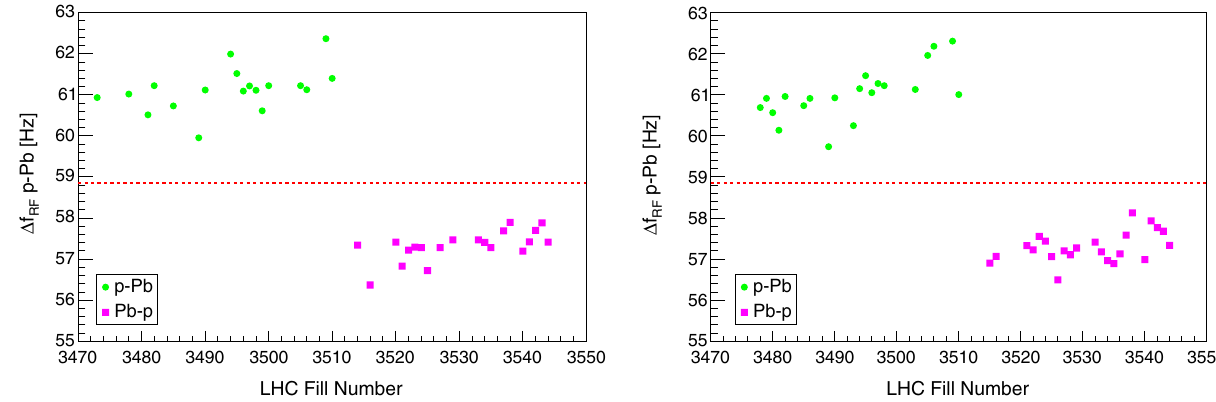
FIG. 12. Time dependence of the frequency difference Δ f of protons and lead ions at 4 TeV = c as a function of the LHC fill number rf in 2013. For the figure on the left, the frequency is reconstructed after the rf cogging (method B), for the figure on the right before rf cogging (method A). The red dotted line is the frequency difference corresponding to an energy of 4 TeV =